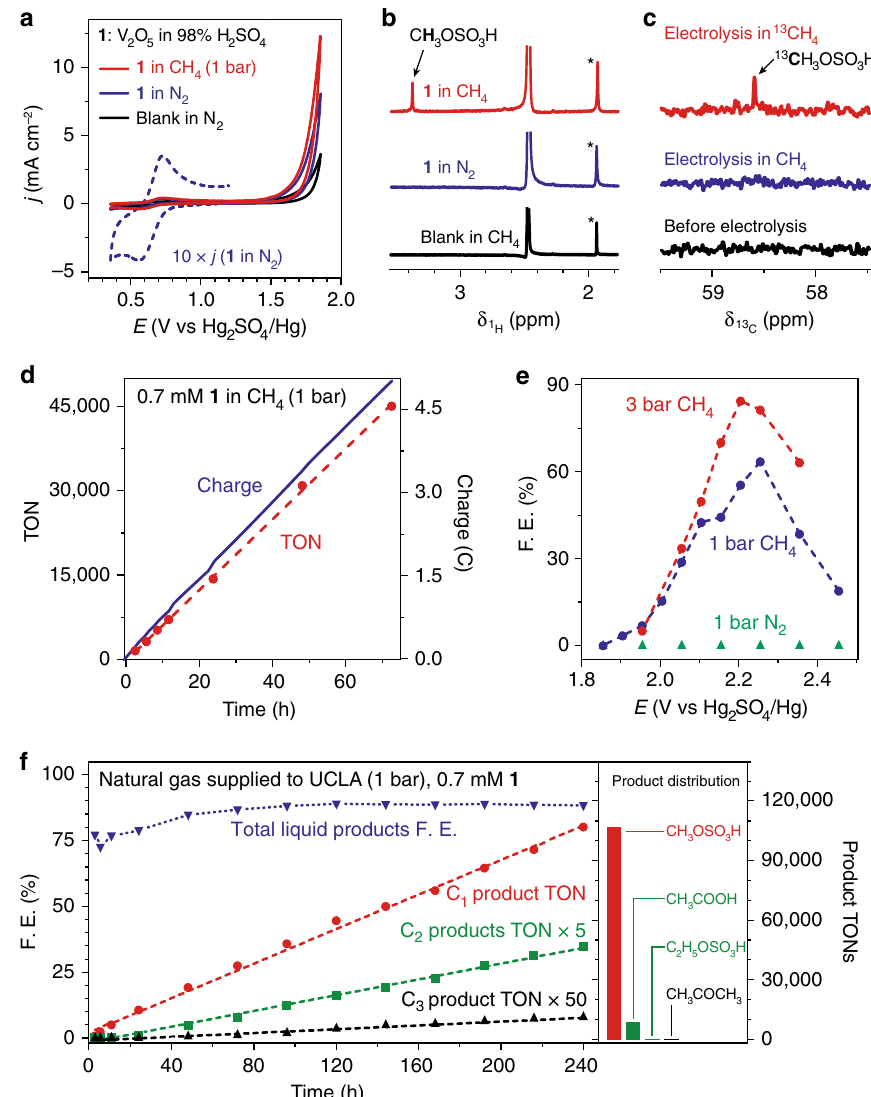
Fig. 2 Electrochemical functionalization of CH 4 and natural gas mixture. a , b Cyclic voltammograms ( a ) and 1 H NMR spectra of liquid samples after 6-h electrolysis ( b ) for 10 mM 1 in 1-bar CH 4 (red), 10 mM 1 in 1-bar N 2 (blue), and blanks without 1 (black). Dashed blue, current density ( j ) of blue trace magni fi ed by a factor of 10. *, internal standard acetic acid. c 13 C NMR spectra of samples before (black) and after electrolysis with 13 CH 4 (red) and CH 4 of natural abundance (blue), respectively. d Calculated TONs (red) and electric charges passed (blue) versus the duration of electrolysis. e F.E. of CH 4 functionalization in 10 mM 1 vs. electrode potential E under 1-bar N 2 (green), 1-bar CH 4 (blue) and 3-bar CH 4 (red). f Cumulative TONs for C 1 (red), C 2 (green, multiplied by a factor of 5), and C 3 products (black, multiplied by a factor of 50) as well as F.E. values of total liquid products (blue) are plotted against the duration of bulk electrolysis. TON values for CH 3 OSO 3 H (red), CH 3 COOH plus C 2 H 5 OSO 3 H (green), and CH 3 COCH 3 (black) within 240 h are shown on the right, respectively. Natural gas mixture supplied by SoCalGas was used as the substrate at ambient pressure. Trace products beyond C 3 were also observed. 100 mV s − 1 and Pt working electrode in ( a ); FTO working electrode in ( b ) to ( f ), and E = 2.255 V vs. Hg 2 SO 4 /Hg in ( b ) to ( d ), and ( f